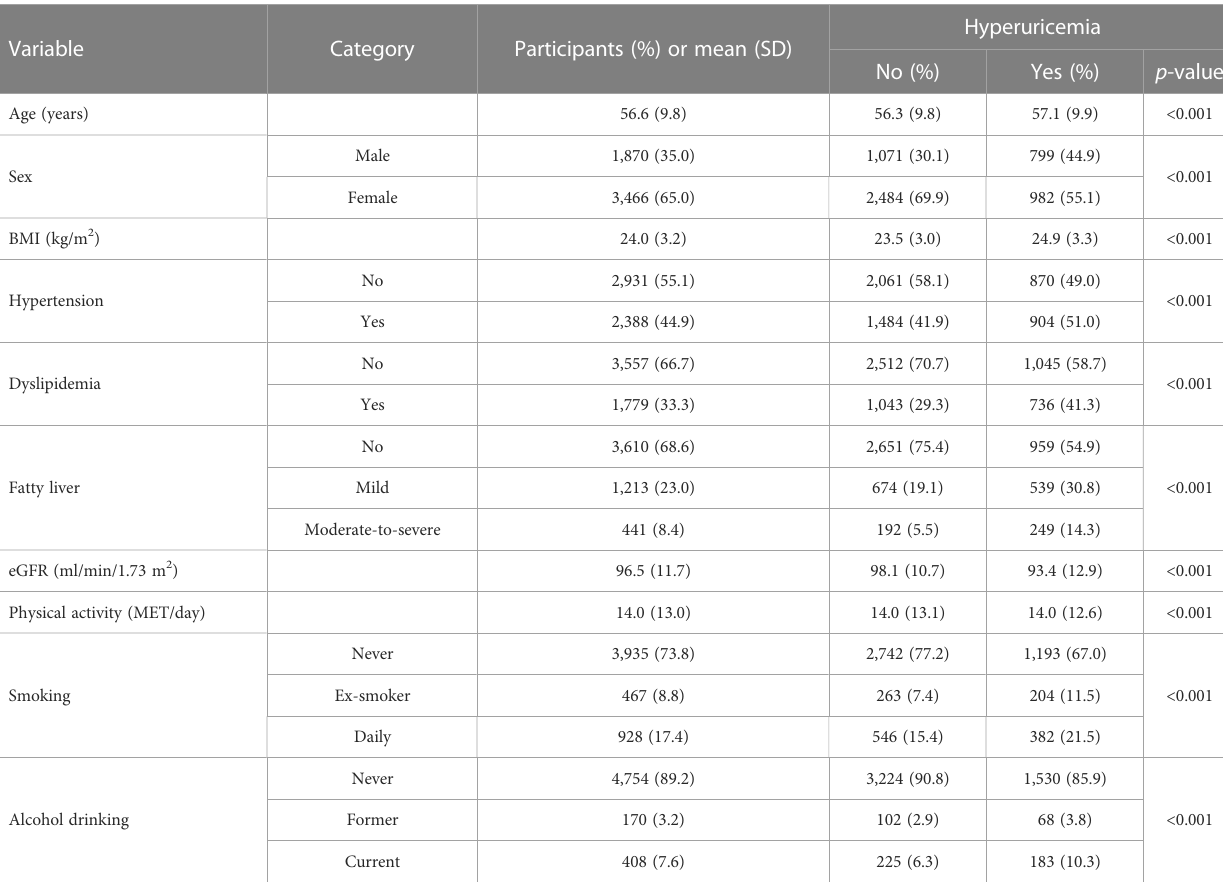
TABLE 1 Characteristics of participants by hyperuricemia